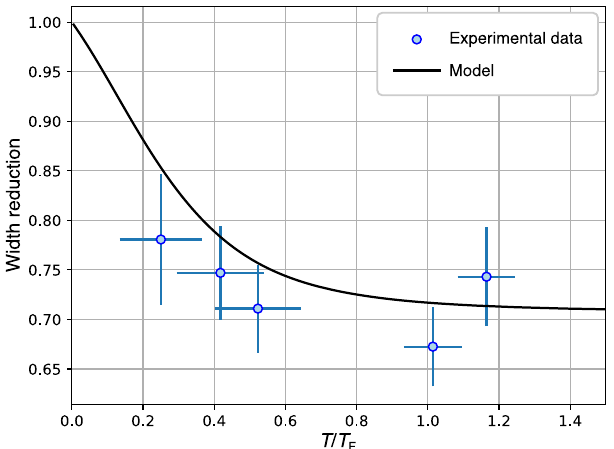
Fig.5|ReductionoftheFWHMduetotheeffectofPauliblockingofstimulated emission. The FWHM is plotted as a function of the temperature T / T F as deter- mined before each experiment. The solid black curve corresponds to the ratio of theexpectedwidthsof S ð ω Þ calculatedusingexpression(6),and S Absorption ð ω Þ .Blue points represent the valuesof the ratioofthe twoplateaus averagedover intervals of T / T F values. Error bars are obtained by binning the data based on their value of T / T F